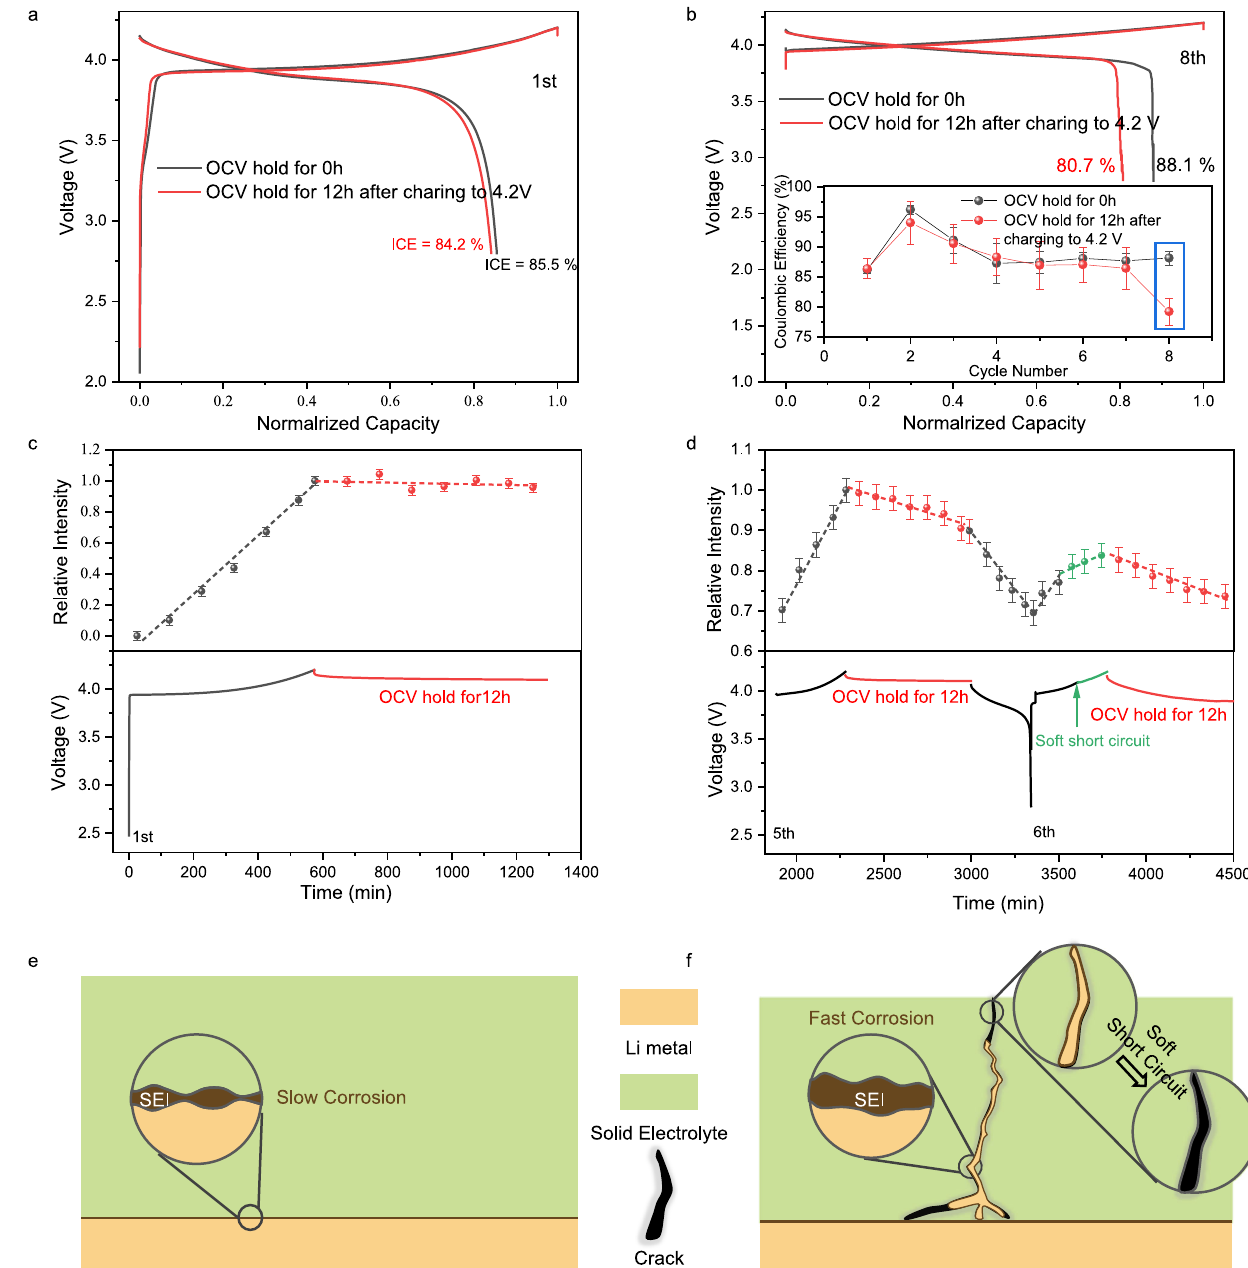
Fig. 6 | The calendar aging of LPS based AFBs. a Charge/discharge curves of the fi rst cycle, with/without 12h of OCV hold after charging to 4.2V. b Charge/dis- chargecurvesofthe8thcycle,with/without12hofOCVholdafterchargingto4.2V (inset: evolution of the Coulombic ef fi ciency during cycling). The error bar repre- sents the standard error for three independent experiments. c , d The integral area